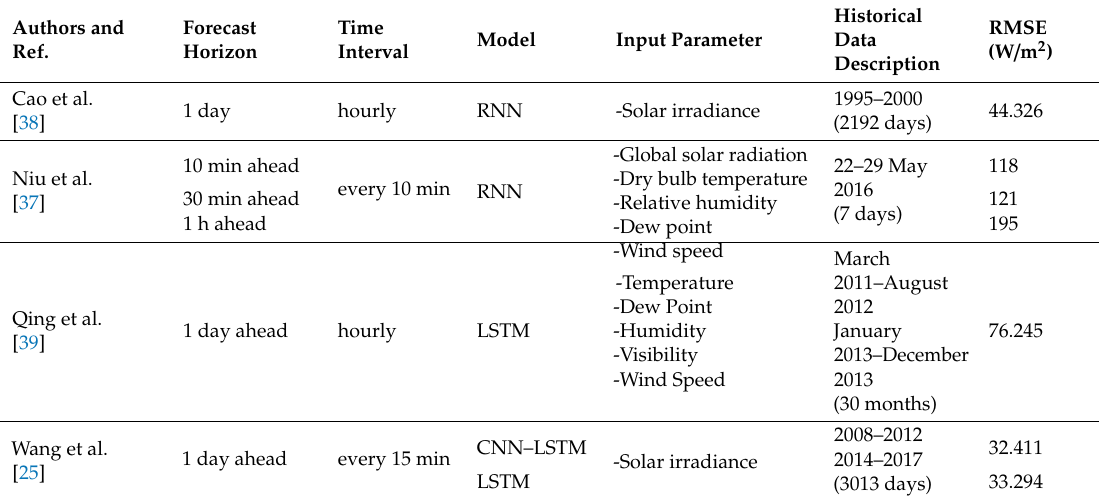
Table 3. Solar irradiance